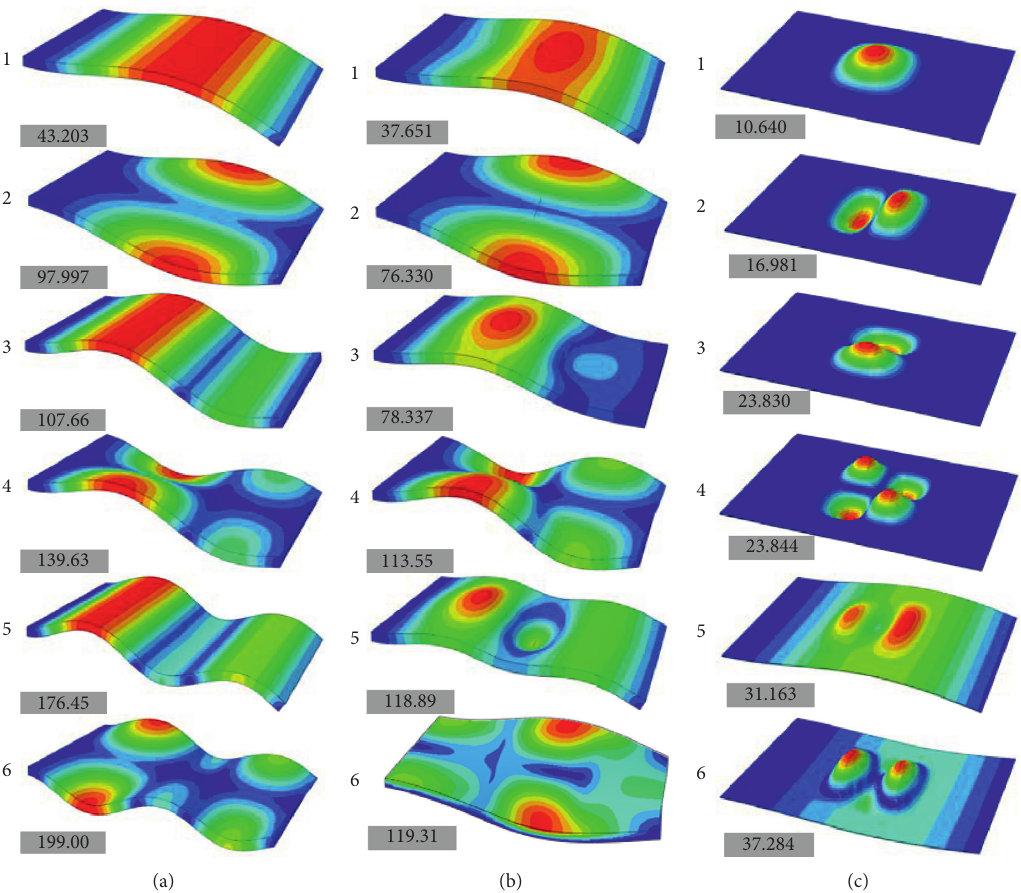
Figure 8: Buckling behavior of specimens: (a) specimen with no defects; (b) [40 ∗ 40-4]; (c) [40 ∗